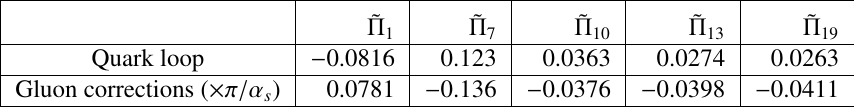
Table 1. Values for the quark loop and gluonic correction contributions to the ˜ ⇧ in GeV units for a , Q 2 , Q 2 benchmark tuple ( Q 2 ) = (1 , 1 . 3 , 1 . 7) GeV 2 . Sum over the three flavours has been made. The 1 2 3 last line is in units of ↵ s /⇡